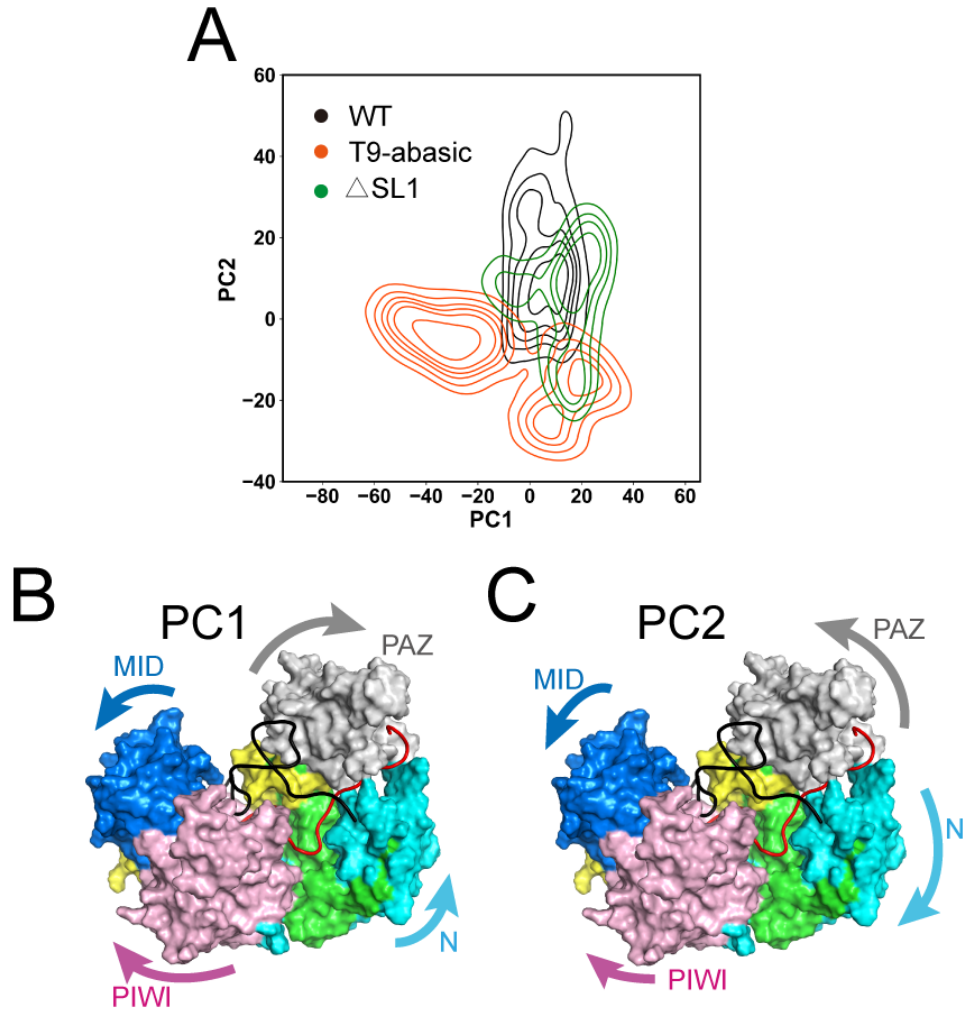
Figure 3. Global conformational transitions of the Ago2–RNA complex. ( A ) Projections of the first and second principal components (PC1 and PC2) from MD simulations of the Ago2 protein in three systems. The domain motion along PC1 ( B ) and PC2 ( C ) was shown.